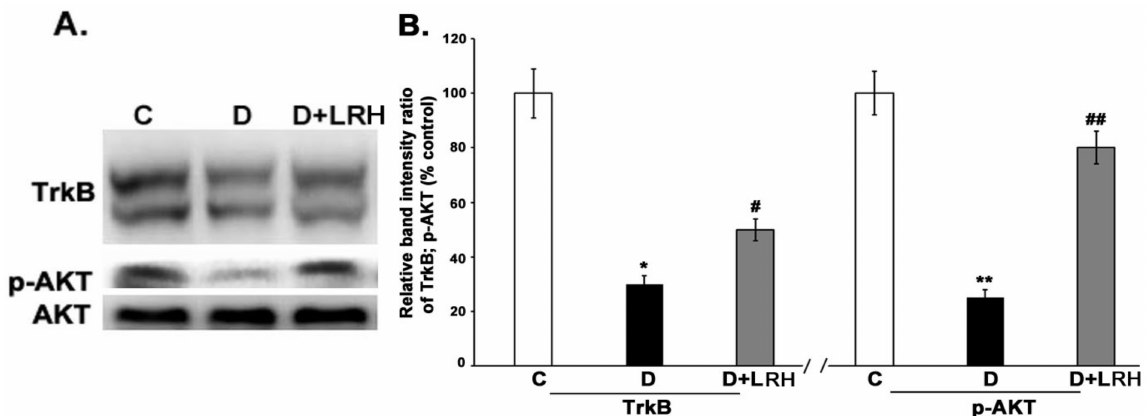
Figure 3. Retinal protein expression of TrkB, AKT, and p-AKT in L. regularis -treated diabetic rats. Densitometry was used to measure the band intensities. Representative immunoblots of TrkB, AKT, p-AKT are shown in Panel ( A ). The bar graph is provided as a percentage of control of TrkB and p-AKT protein band intensities ratios (Panel ( B )). Values are means ± SEM for six determinations. *,** p < 0.01 shows a significant variation from their controls; #,## p < 0.05 suggests a marked difference from diabetic